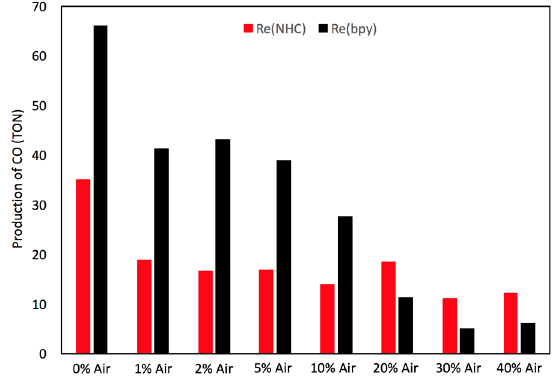
Figure 6. Maximum TON values for Re(pyNHC-PhCF 3 )(CO) 3 Cl and Re(bpy)(CO) 3 Cl with varying percentages of air.